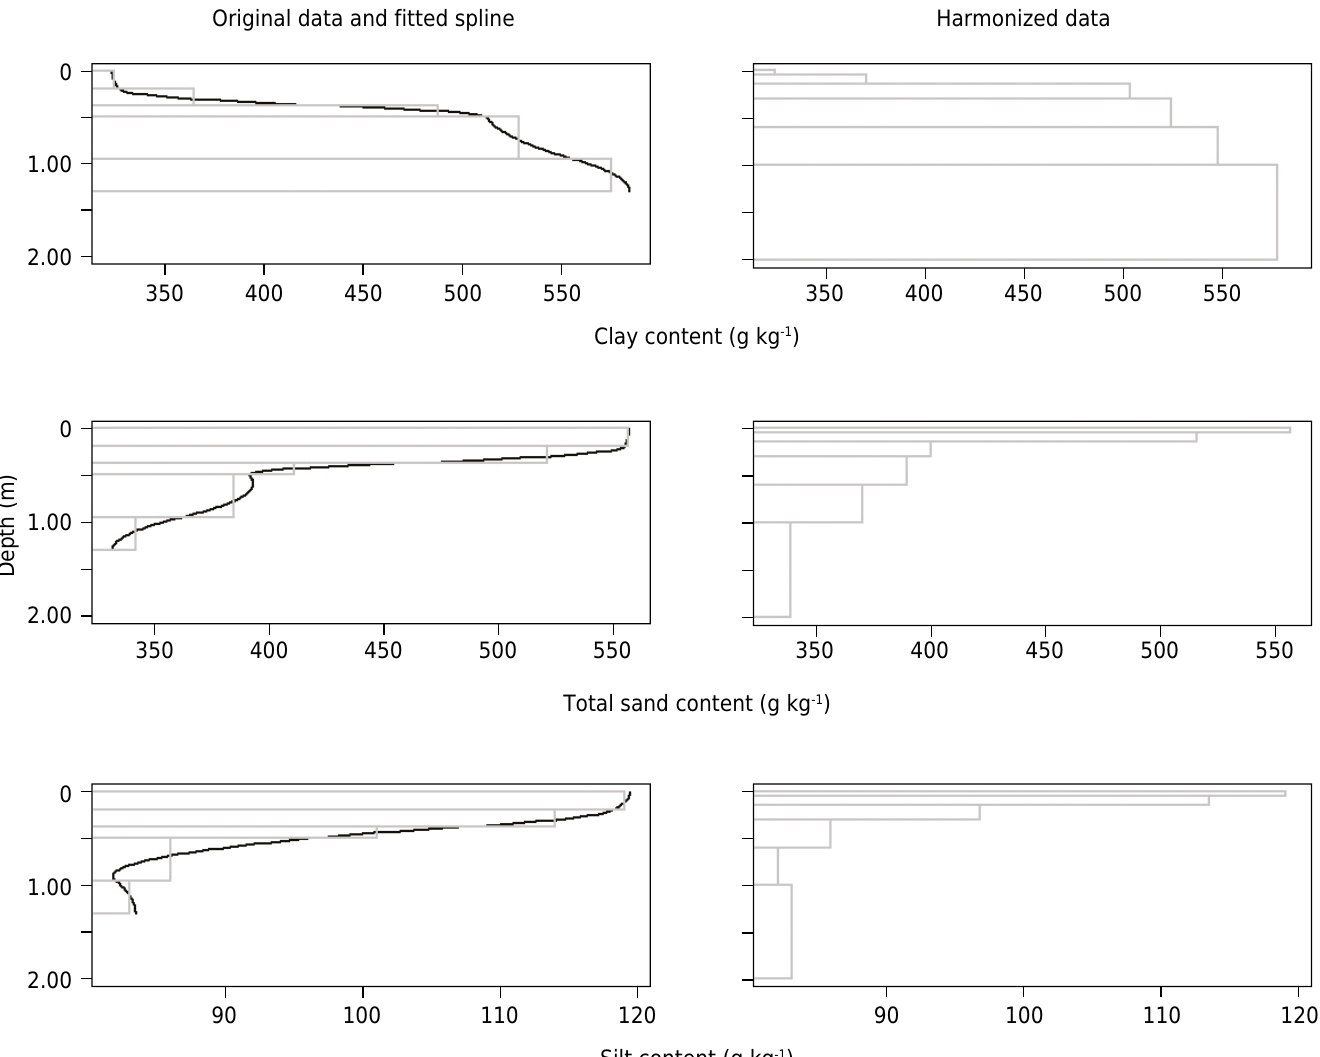
Figure 2. An example of clay, sand, and silt content variability with depth within a soil profile, with original data and harmonized data created from a spline